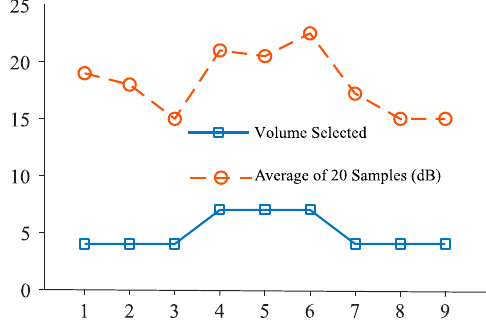
Figure 9. Volume selection for 20-decibel-level inputs.